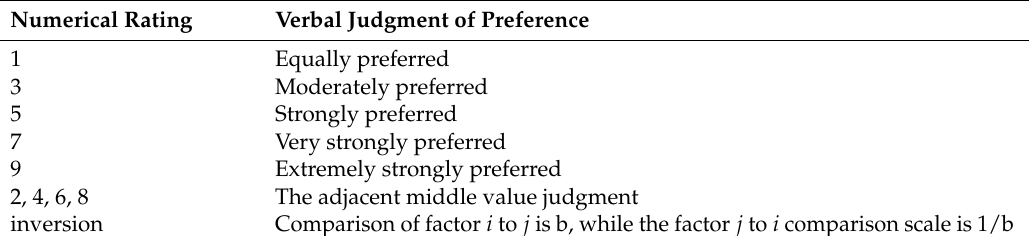
Table 4. The importance of the pair-wise comparison judgment